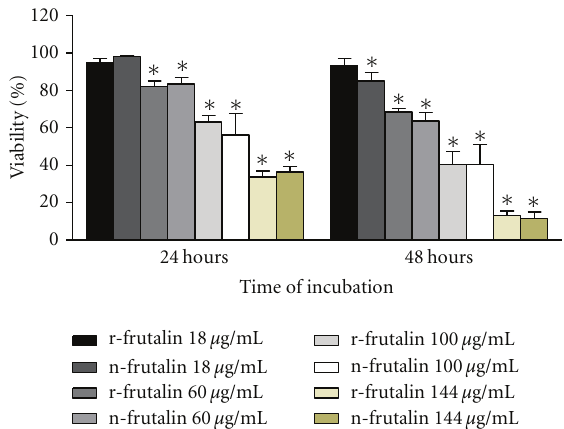
Figure 1: E ff ect of di ff erent concentrations of n-frutalin and r- frutalin on HeLa cells proliferation at 24 and 48h. Each time point is shown as mean ± SEM of at least 3 replicates ( n = 3); ∗ P < 0 . 05. No statistically significant di ff erences were observed in terms of toxicity between the same concentrations of recombinant and native frutalin, regardless of concentration and time point